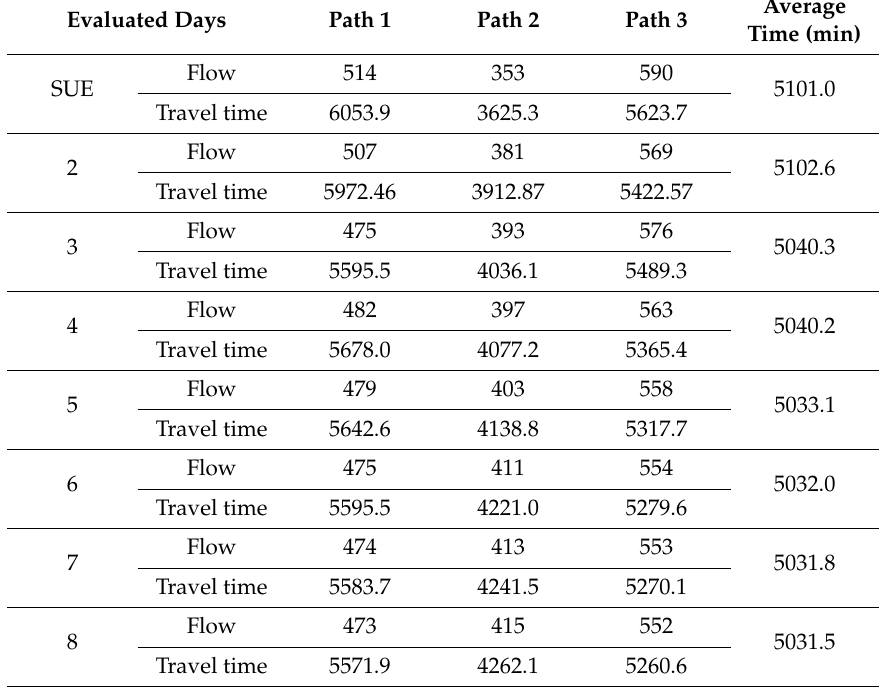
Table 6. Path flow and travel time according to the day-to-day